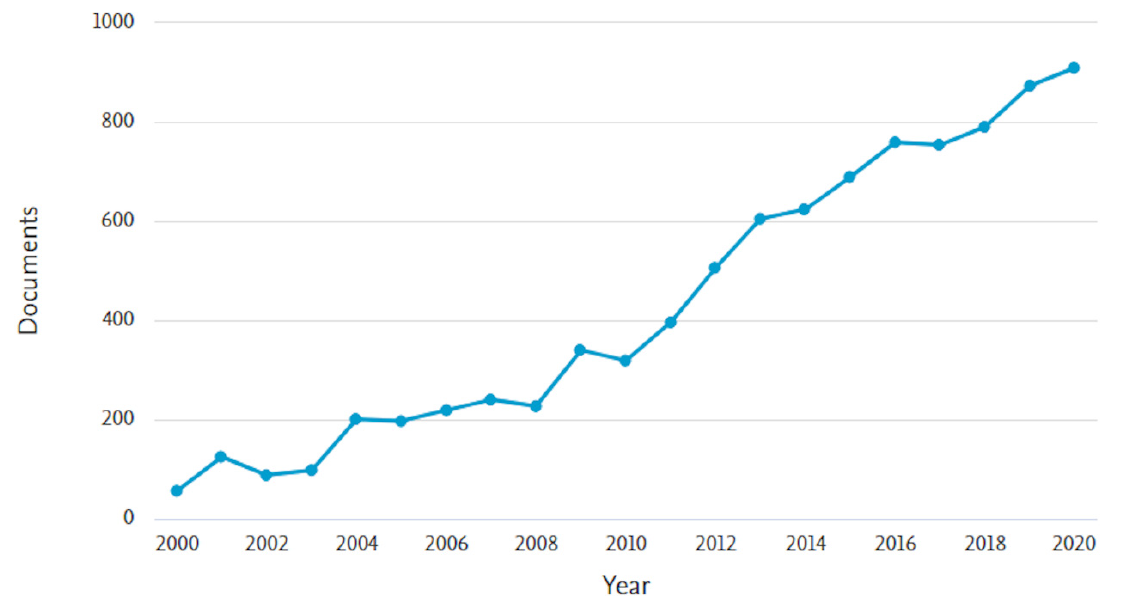
Figure 1. Number of papers per year with topic of molecularly imprinted polymers (Scopus platform, from 2000 to 2020).